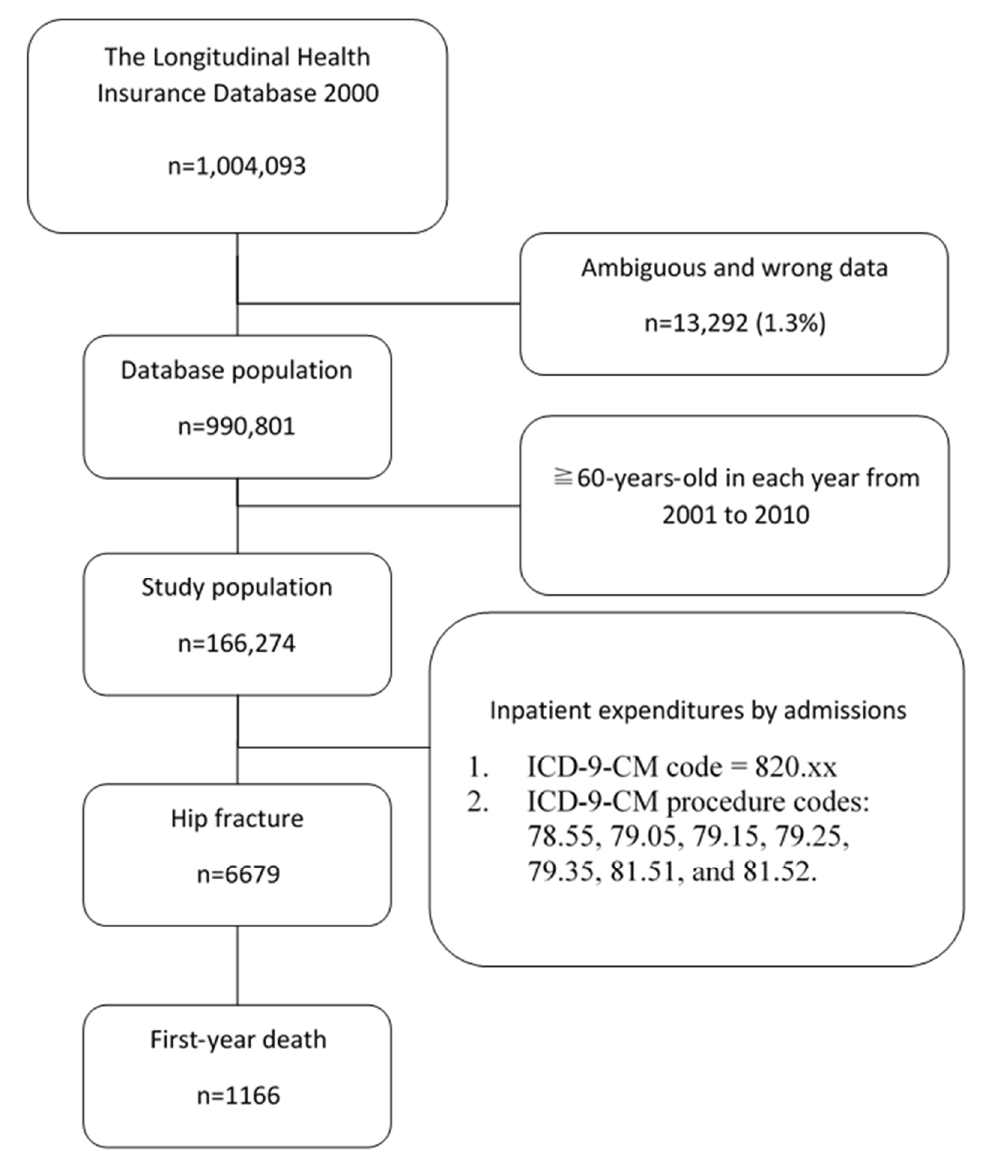
Figure 1. Diagram of study population.